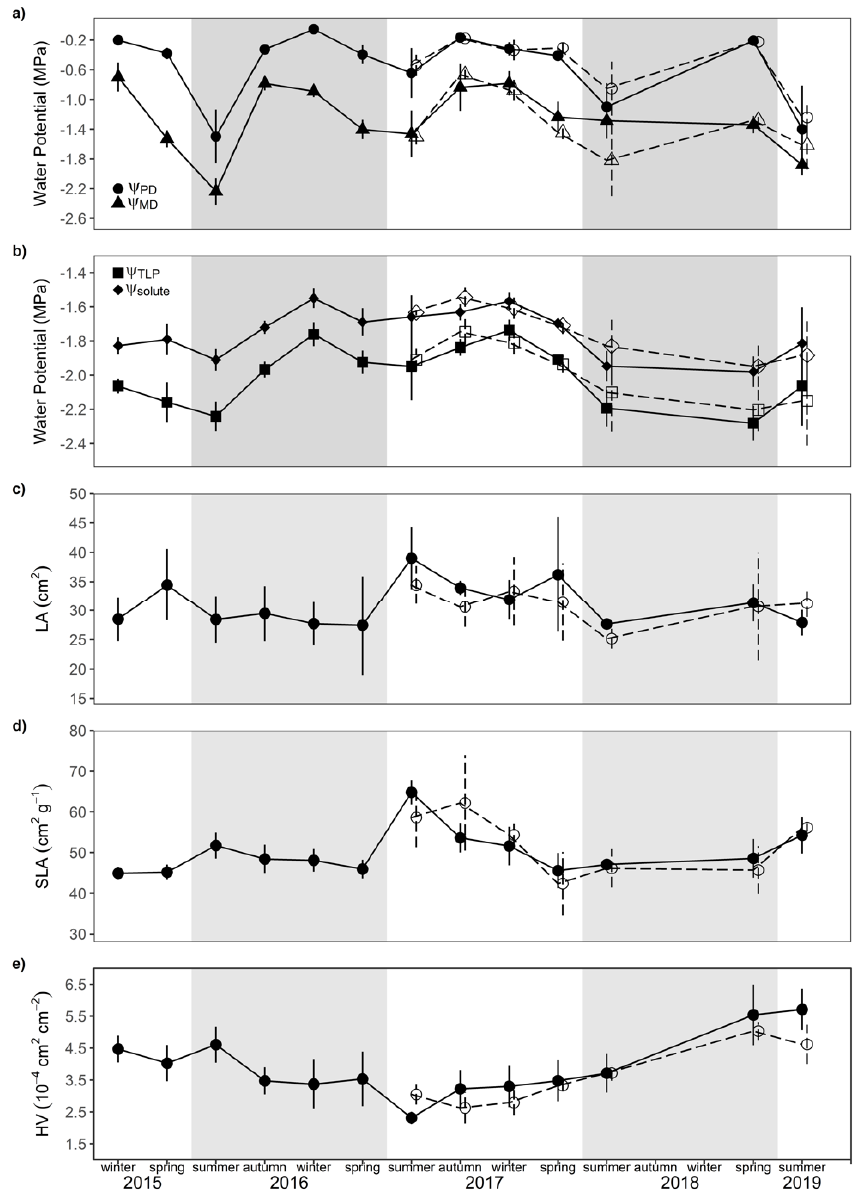
Figure 4. Seasonal changes in water relation traits in Eucalyptus obliqua for control (closed symbols) and throughfall reduction (open symbols) plots. The following traits are represented: ( a ) Pre-dawn ( Ψ PD , circles) and midday leaf water potentials ( Ψ MD , triangle), ( b ) water potential at turgor loss point ( Ψ TLP , square) and solute water potential at full turgor ( Ψ solute diamond), ( c ) leaf area (LA), ( d ) specific leaf area (SLA), and ( e ) Huber Value